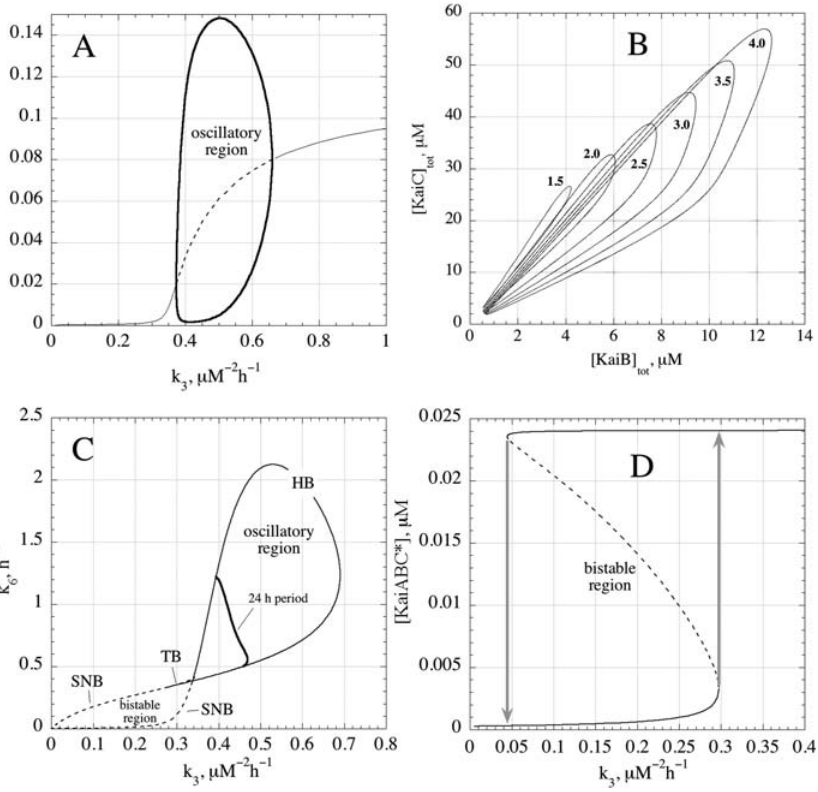
Figure 4. Oscillatory and Bistable Regions (A) Stable oscillations exist only for certain rate constant values as shown here for variations in k 3 (0.373 l M (cid:1) 2 h (cid:1) 1 (cid:2) k 3 (cid:2) 0.660 l M (cid:1) 2 h (cid:1) 1 ; all other rate constants as in Figure 2). The dashed line within the oscillatory region indicates the unstable steady state, which becomes stable outside the oscillatory region (solid lines). (B) The oscillations are crucially dependent on the total concentrations of KaiA, KaiB, and KaiC. The figure shows the oscillatory regions as closed loops in the concentration space of total KaiC ([KaiC] tot ) and total KaiB ([KaiB] tot ) when total concentrations of KaiA ([KaiA] tot are varied from 4.0 l M to 1.5 l M (see numbers in graph). The model predicts that the region of oscillations shrinks as the total KaiA concentration is lowered. (C) The oscillatory and bistable regions (Figure 3A and 3B) are found within a so-called ‘‘ cross-shaped diagram ’’ shown here in the k 6 –k 3 parameter space. Such diagrams have been observed in chemical oscillatory systems [39]. In more technical terms, HB denotes a Hopf bifurcation, SNB a Saddle Node bifurcation, and TB the Takens-Bogdanov bifurcation. The solid heavy line inside the oscillatory region indicates oscillations with a period length of 24 h. (D) The model can show bistability/hysteresis when for example k 6 is reduced from 0.9 h (cid:1) 1 to 0.1 h (cid:1) 1 . Steady state levels of KaiABC* are shown as a function of k 3 . The dashed line (0.0446 l M (cid:1) 2 h (cid:1) 1 (cid:2) k 3 (cid:2) 0.297 l M (cid:1) 2 h (cid:1) 1 ) indicates unstable steady states and the bistable region. Solid lines show stable steady states. DOI: talytic loop are well represented by the model in Figure 1 on which we focus here.